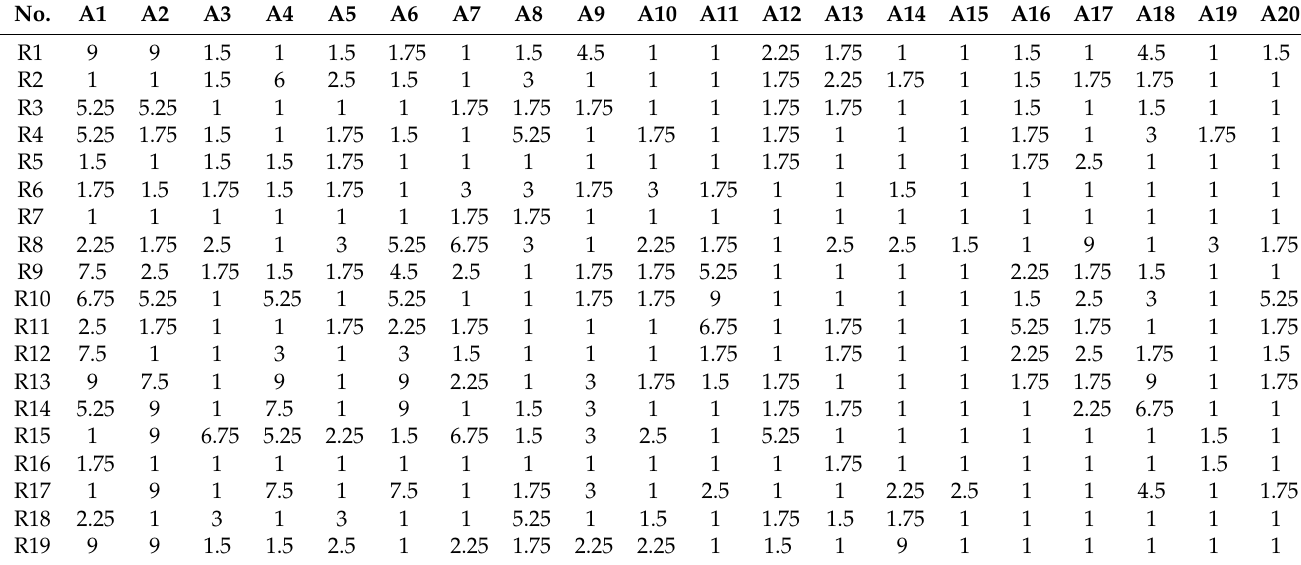
Table 15. The incidence matrix between SSCRs and agility